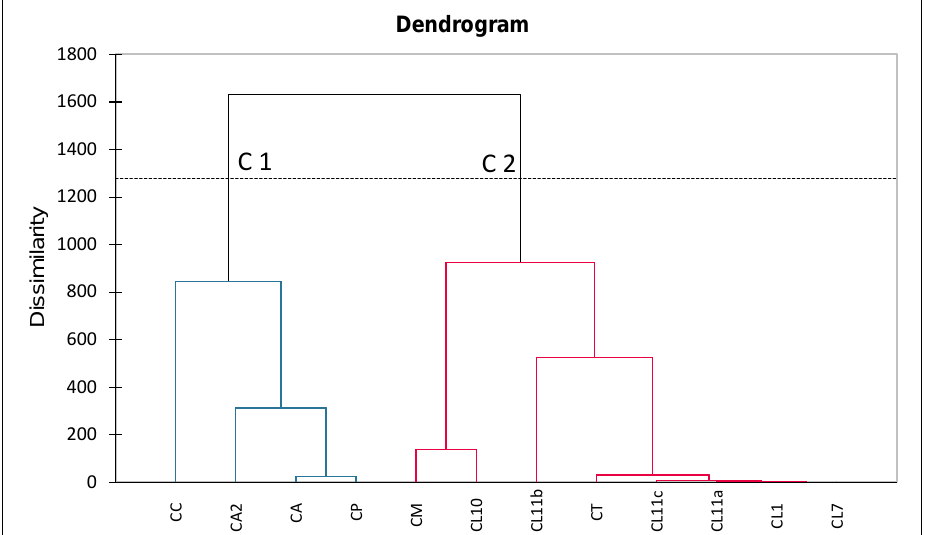
Figure 3. Dendrogram (AHC analysis) representing the chemical composition dissimilarity relation- ships of 12 essential oil samples (observations) obtained by Euclidian distance dissimilarity using the aggregation criterion of Ward’s method. Two main groups of samples (C1 and C2) were found.